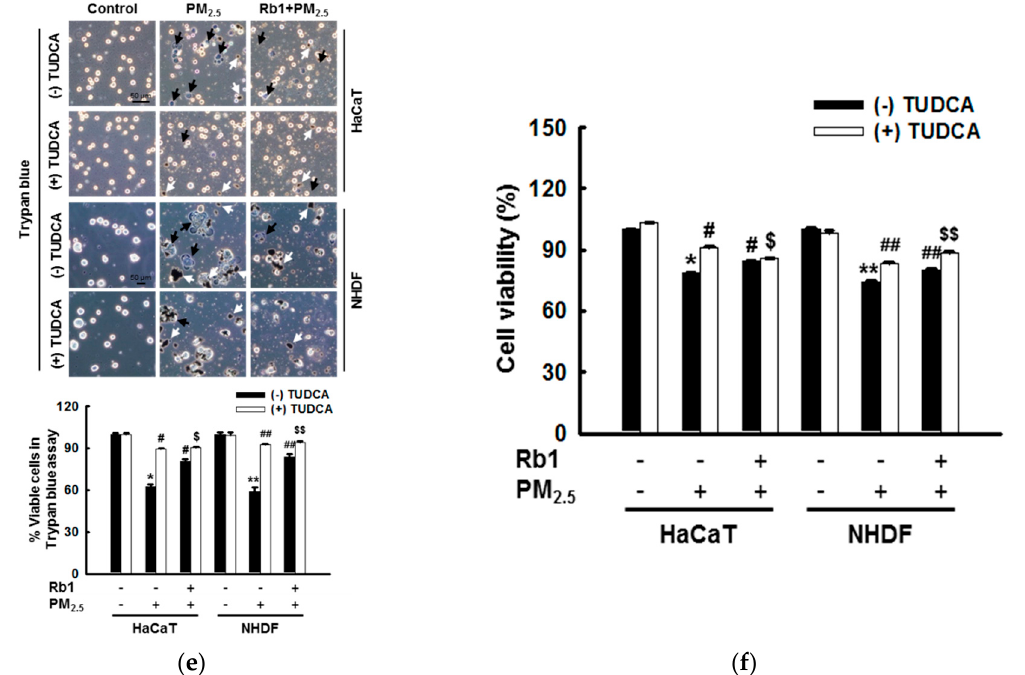
Figure 7. Ginsenoside Rb1 confers protection against ER stress-induced apoptosis. ( a, b ) Cells were pretreated with ginsenoside Rb1 for 1 h, and then treated with the ER inducer DTT for 24 h. ( a ) Apoptosis was detected with Hoechst 33342 dye, and ( c ) the cell viability was measured using the MTT assay. ( a,b ). *,** p < 0.05 compared to the control groups of both HaCaT and NHDF cells, respectively; # , ## p < 0.05 compared to DTT-treated groups of both HaCaT and NHDF cells, respectively. ( c – e ) Cells were pre-treated with ginsenoside Rb1 (40 µ M) or TUDCA (1 µ M) for 1 h, then treated with PM 2.5 (50 µ g / mL) and incubated for 24 h. ( c ) The amount of ATP in the cells was measured using an ATP determination kit. ( d ) The cells were stained with Hoechst 33342 and images were acquired using a fluorescence microscope to detect apoptosis. Arrows indicate apoptotic cells. ( e ) Cells were stained with trypan blue reagent and images were taken using a phase contrast microscope to detect cell viability. Black arrows indicate dead cells and white arrows indicate PM 2.5 . ( f ) Cell viability was assessed using MTT assay. ( c – f ) *,** p < 0.05 compared to the control groups of both HaCaT and NHDF cells, respectively; # , ## p < 0.05 compared to PM 2.5 -treated groups of both HaCaT and NHDF cells, respectively. $ , $$ p < 0.05 compared to ginsenoside Rb1 + PM 2.5 groups of both HaCaT and NHDF cells, respectively.